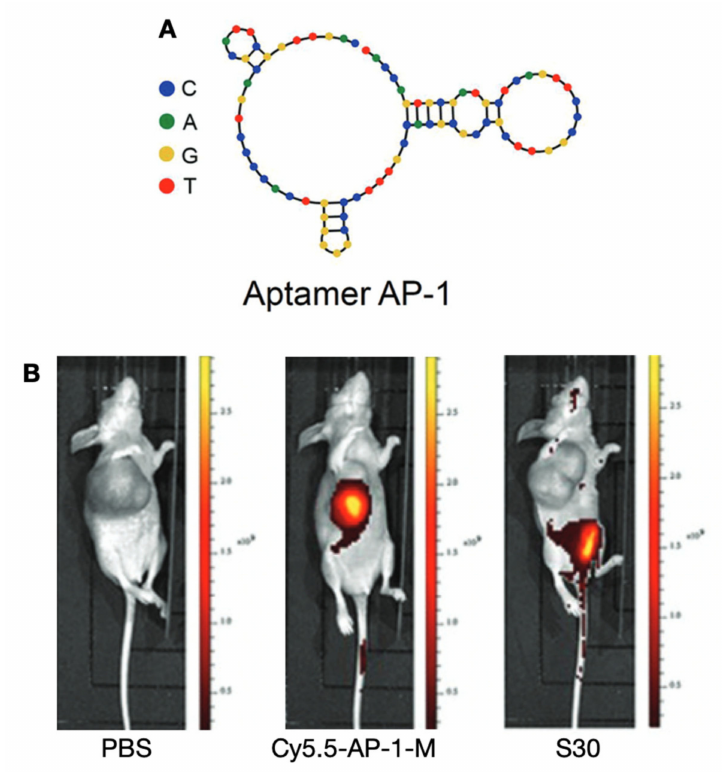
Figure 13. ( A ) Predicated structure of aptamer precursor AP-1. ( B ) Distribution of AP-1-M in a FRO xenograft model on fluorescence imaging at 48 h post-injection of PBS, Cy5.5-labeled AP-1-M, and control aptamer S30. Reproduced with permission from [15], copyright 2013 Royal Society of